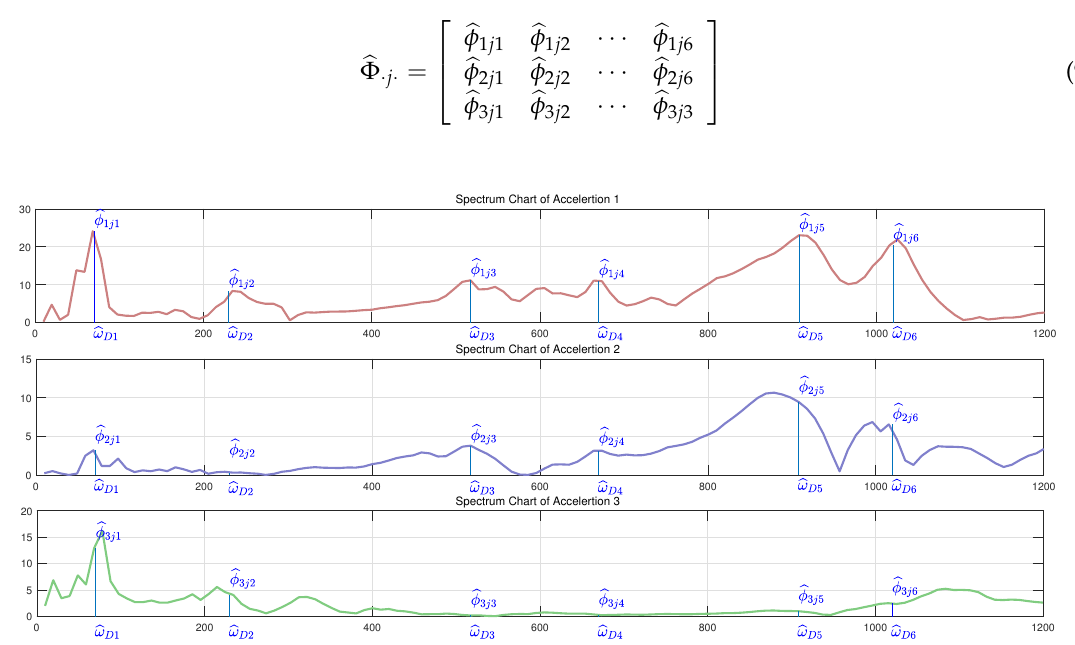
Figure 6. Joint displacement and current during the